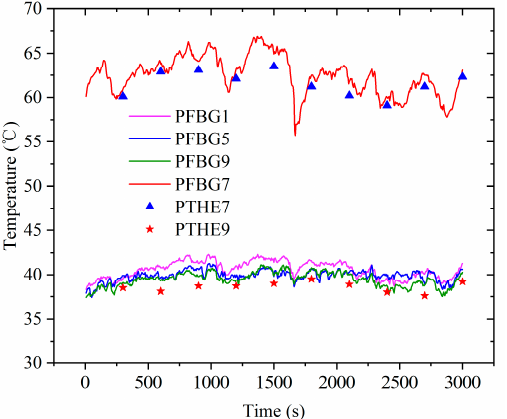
Figure 7. Temperature measurement results of photovoltaic panel surface.